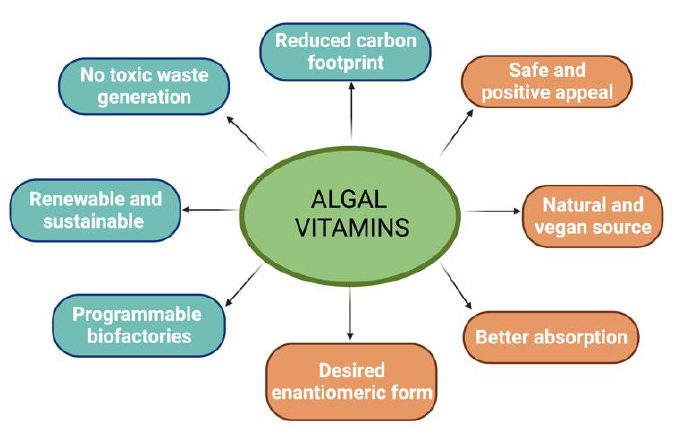
Figure 2. Advantages of algae and algal vitamins (and provitamins). Orange boxes outline advantages of algae-derived vitamins, whereas green boxes express advantages of using algae as vitamin sources.